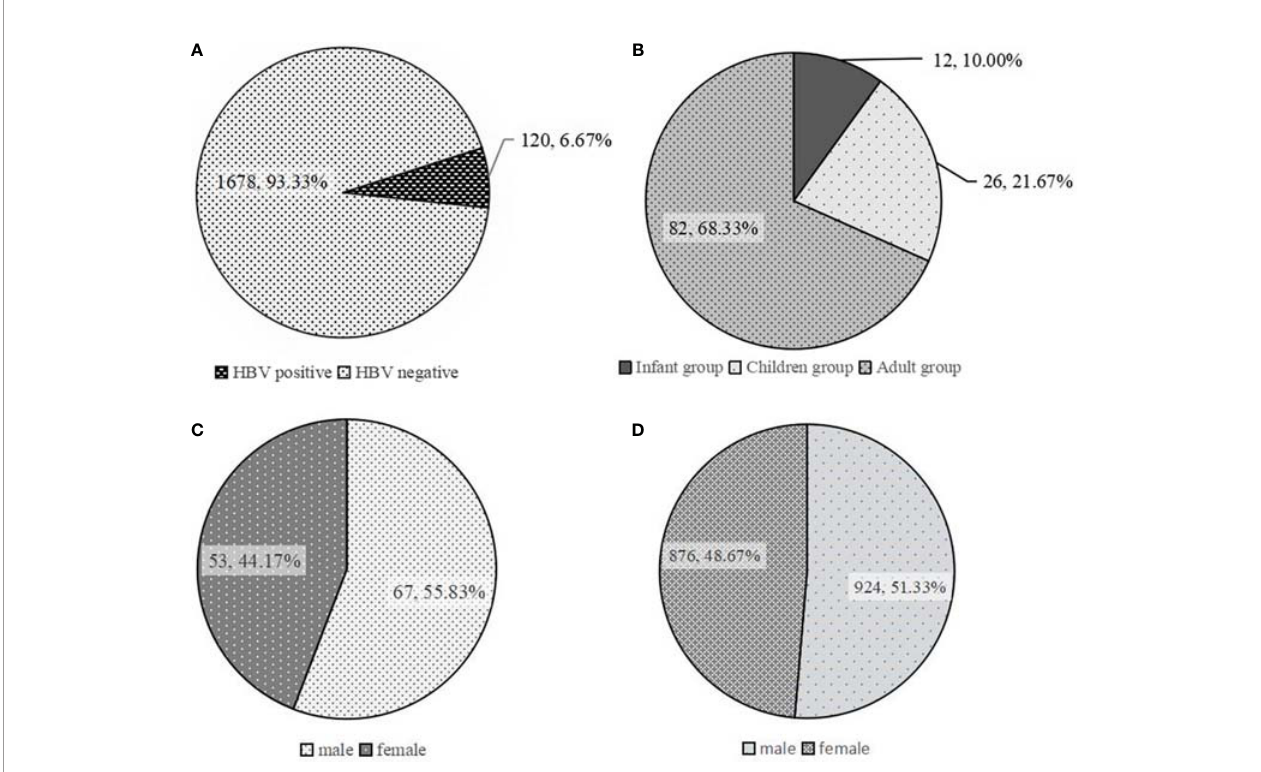
FIGURE 2 | Analysis of characteristics of HBs-Ag-positive participants. (A) The proportion of HBs-Ag-positive participants in all participants to be tested. (B) The age distribution in HBs-Ag-positive participants. (C) The proportion of males and females in HBs-Ag-positive participants. (D) The proportion of males and females in all participants to be